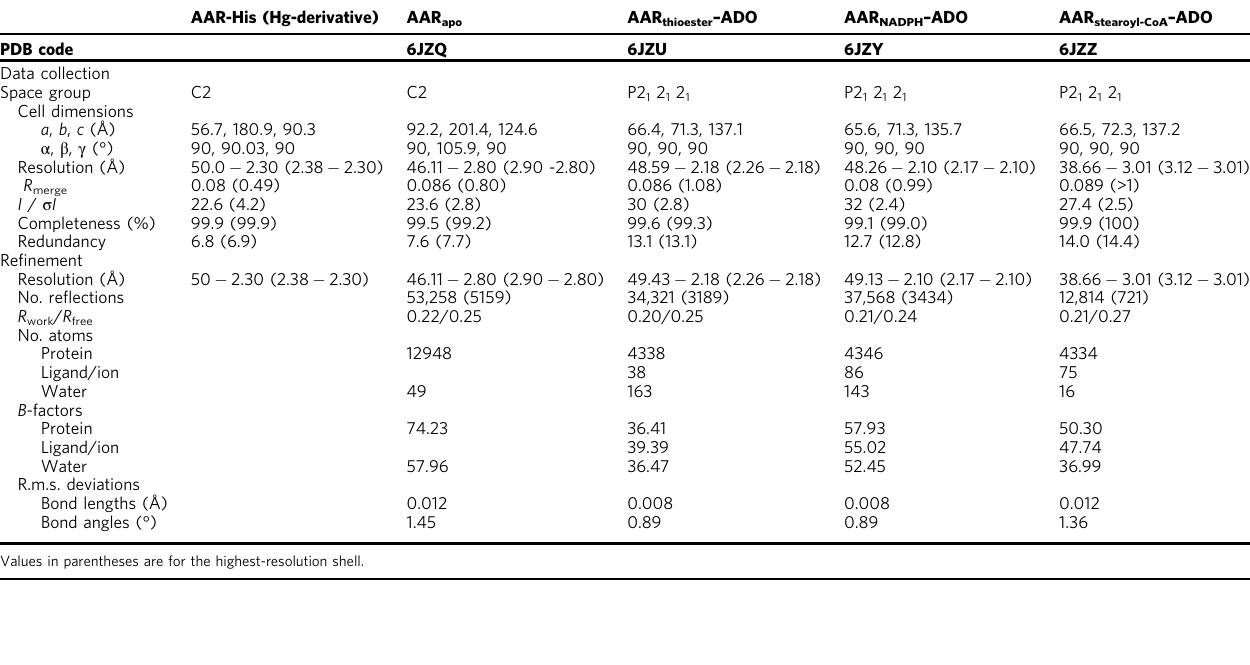
Table 1 Summary of data collection and structure re fi nement.